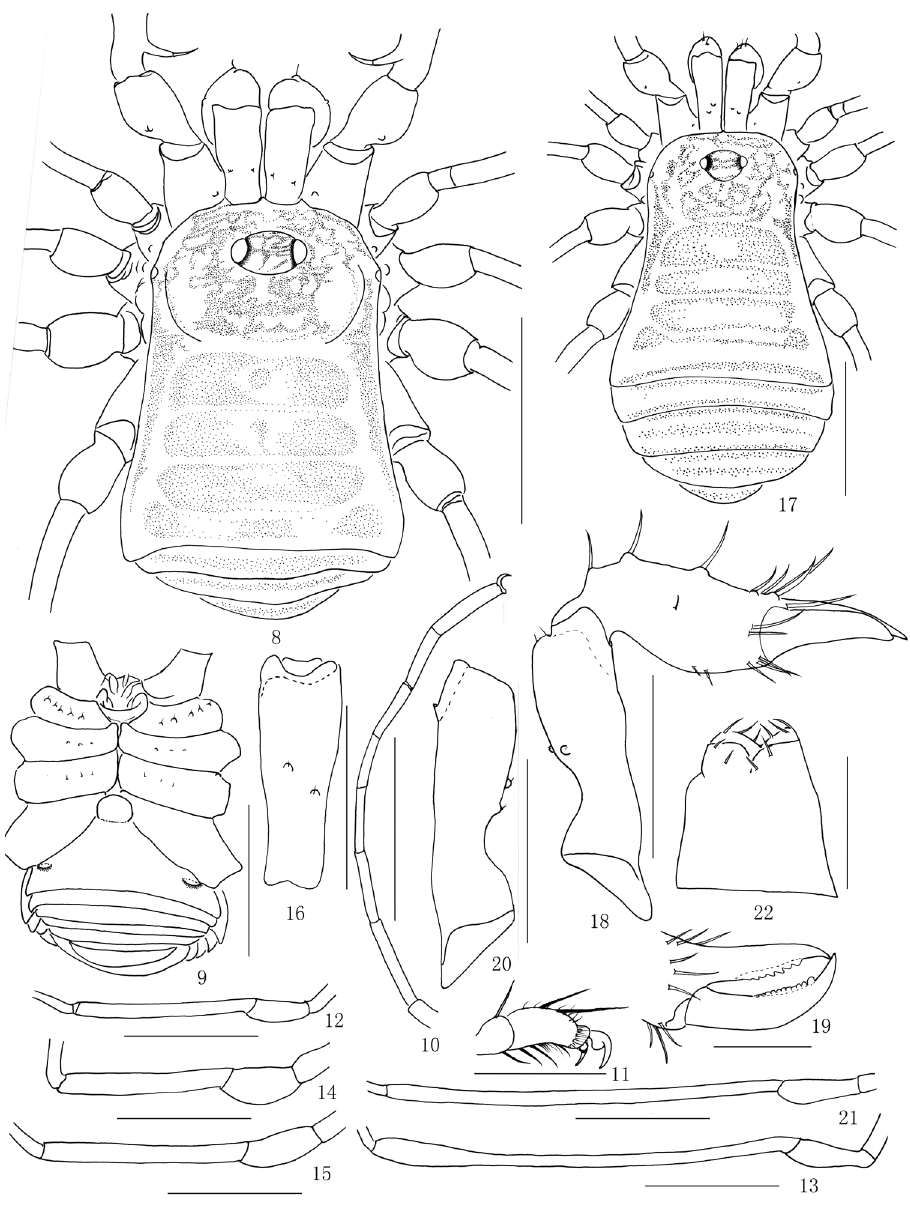
Figures 8–22. Lobonychium palpiplus Roewer, 1938, male (MHBU-Opi-20151208m) ( 8–16 ), female (MHBU-Opi-20151208f) ( 17–22 ) 8 Body, dorsal view 9 Same, ventral view 10 Right tarsus I, retro- lateral view 11 Distal segment of right tarsus III, retrolateral view 12–15 Patellae and tibiae of left legs, prolateral view 12 Leg I 13 Leg II 14 Leg III 15 Leg IV 16 Basal segment of right chelicera, dorsal view 17 Body, dorsal view 18 Right chelicera, ectal view 19 Cheliceral fingers, frontal view 20 Basal segment of left chelicera, ectal view 21 Patella and tibia of left leg II, prolateral view 22 Ovipositor, ventral view. Scale bars: 1 mm ( 8–9, 12–15, 17, 21 ); 0.5 mm ( 10, 16, 18, 20 ); 0.25 mm ( 11, 19, 22